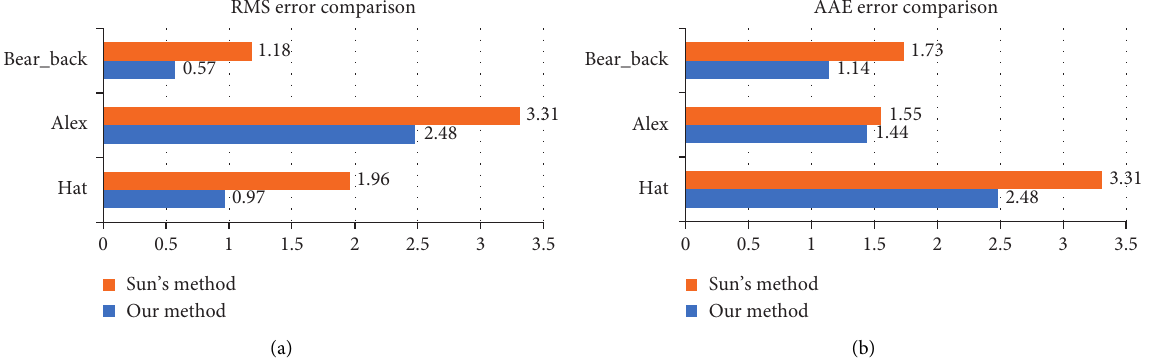
Figure 10: Comparisons of RMS and AAE. (a) RMS error. (b) AAE